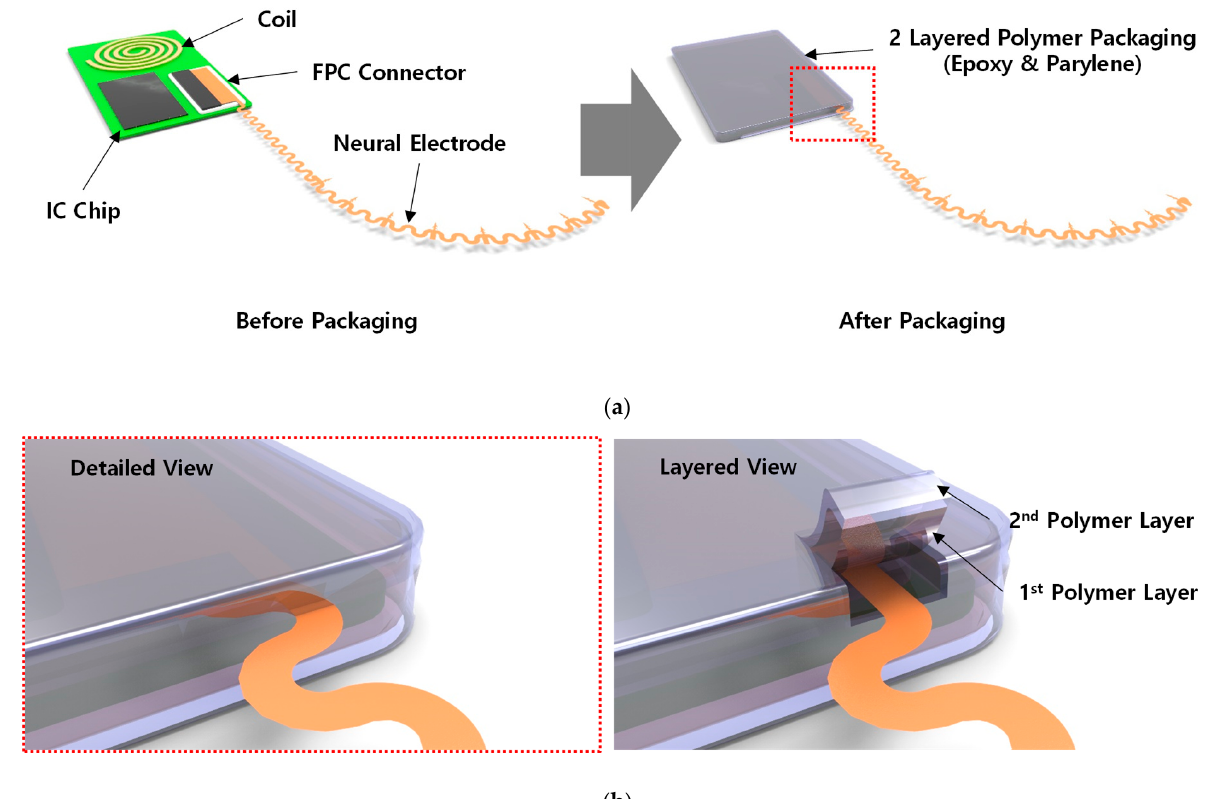
Figure 1. Concept of implantable biocompatible packaging. ( a ) Overall view. ( b ) Enlarged view of the feedthrough of the layered polymer package (dotted rectangle in red color in ( a )). The rectangular test samples used are as defined in Figure 2a. The test PSPI samples were fabricated as follows: (a) PECVD (Plasma–enhanced chemical vapor deposition) ox- ide of 300 nm was deposited on a silicon substrate; (b) PSPI was coated and patterned atop the PECVD oxide layer; (c) the patterned PSPI was fully cured at 300 °C for 1 h; (d) BOE etching was conducted to remove the PECVD oxide; (e) the PSPI strips were completely released from the Si substrate. Figure 2b shows the released PSPI samples.